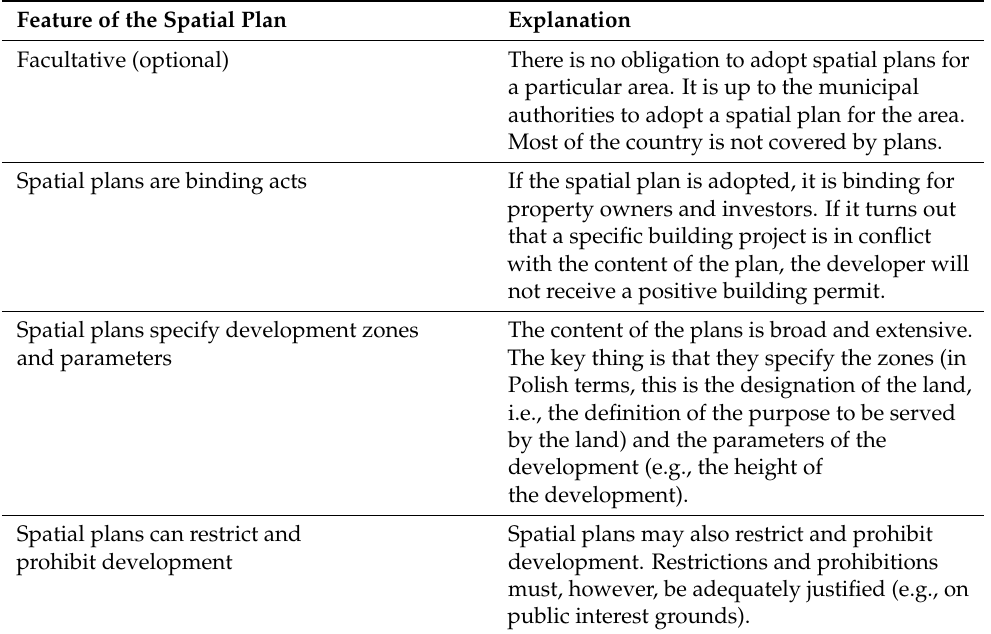
Table 2. Characteristics of Polish spatial plans at local